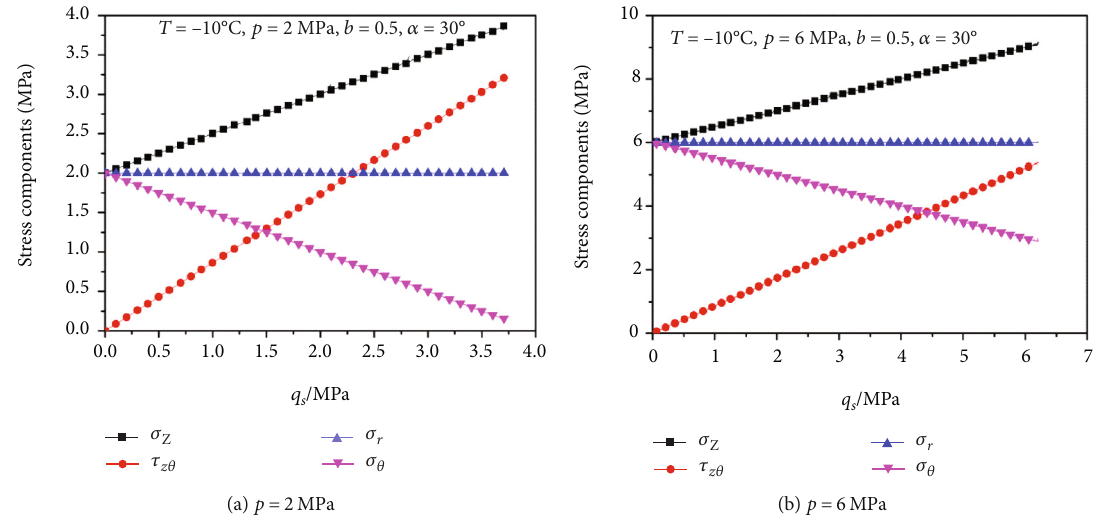
Figure 10: Relationships between shear stress and stress components of the FSS.